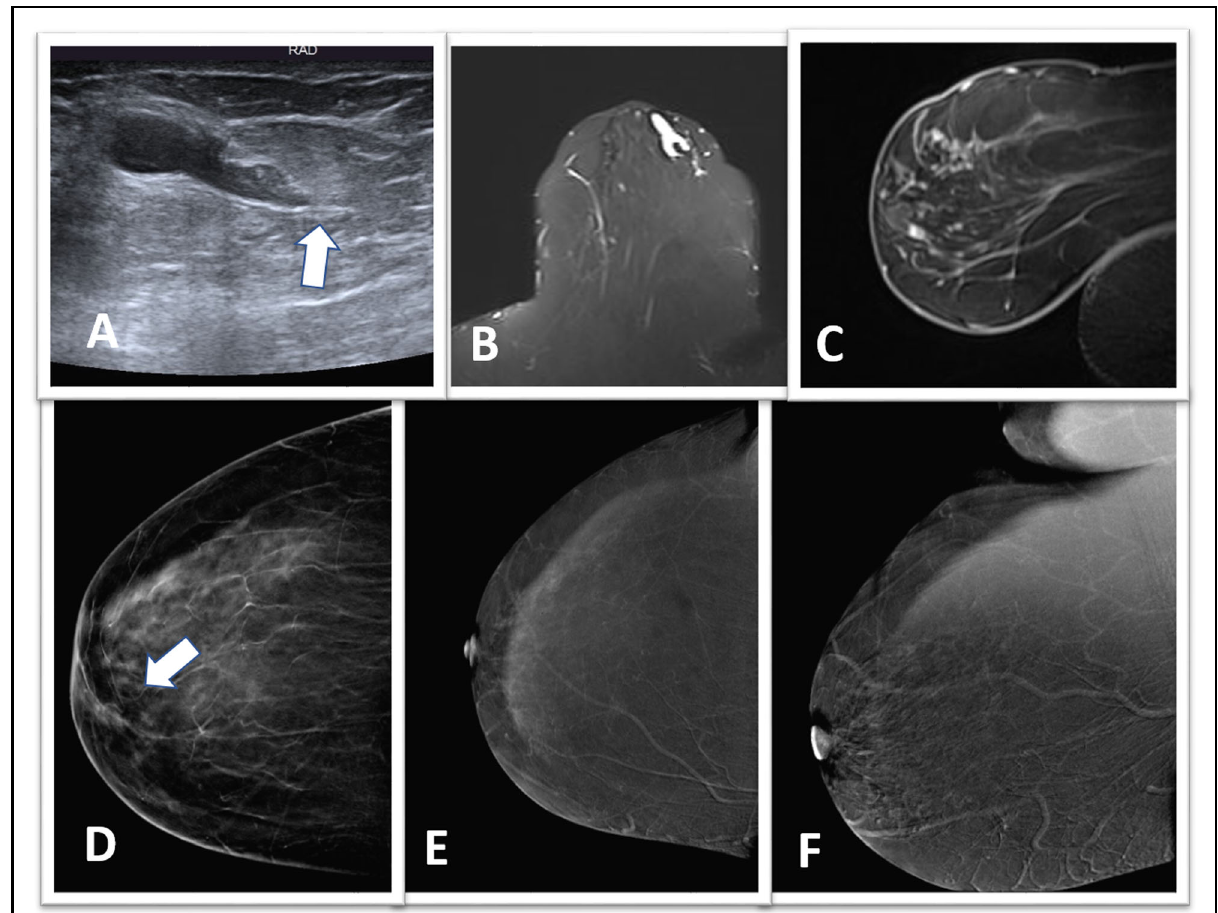
Fig. 3 A 54-year-old lady presenting with right nipple yellowish discharge. a 2D HHUS revealed focal dilated duct at 5 o ’ clock with an intraductal echogenic soft tissue component. b MRI-TIRM revealed dilated branching duct of high signal. c Sagittal DCE-MRI revealed an intraductal- enhancing mass lesion of dynamic curve type I. d CC digital mammogram shows a linear dense structure at the lower inner quadrant (arrow). On recombined CESM ( e , f ), there was no enhancement. Pathology revealed: intraductal